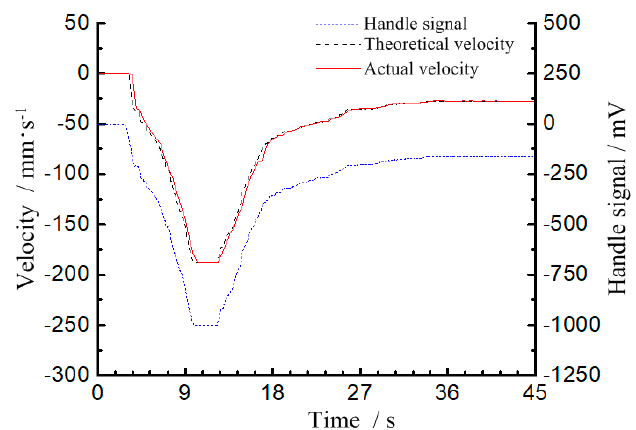
Figure 10. Curve of the forklift descending velocity and handle signal.